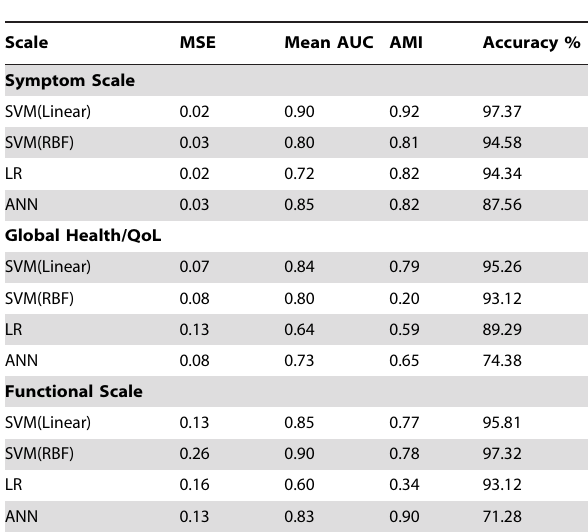
Table 5. The performance comparison of four machine learning algorithms on symptom, global health/QoL and functional scales for the prediction of post treatment cervical cancer quality of life